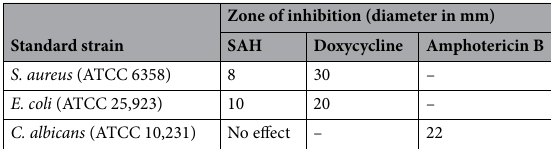
Table 4. Antimicrobial activity of